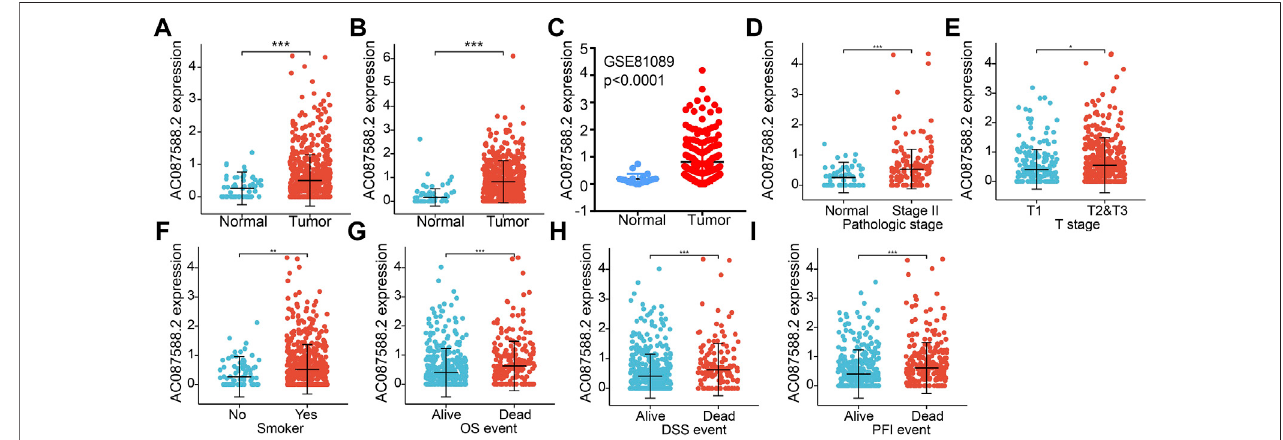
FIGURE 1 | AC087588.2 was overexpressed in LUAD. (A – C) AC087588.2 was overexpressed in LUAD and LUSC examined by TCGA and GEO datasets. (D – I) CorrelationbetweenAC087588.2expressionandclinicalparameters, includingthepathologicalstage,Tstage, smoking,overallsurvivalevent,disease-speci fi csurvival event, and progression-free survival event. * p < 0.05, ** p < 0.01, and *** p <